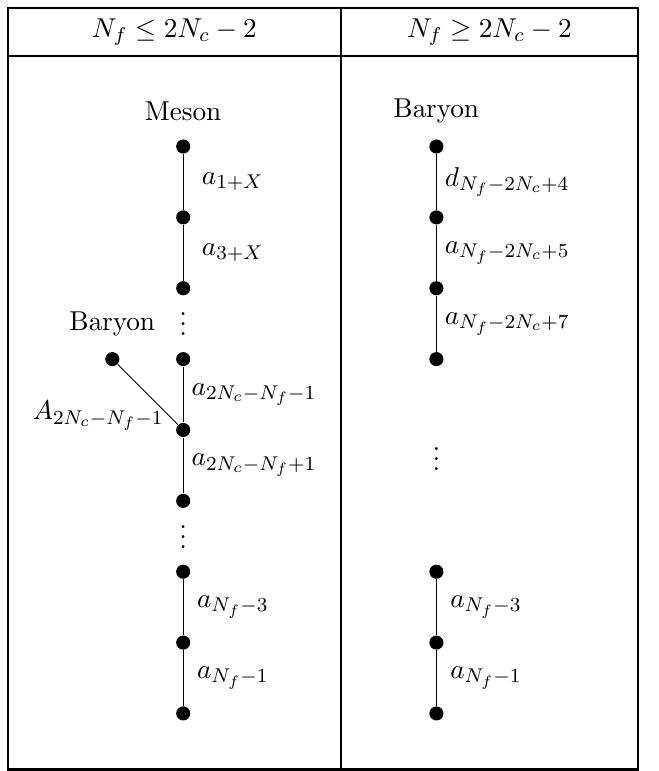
Table 7 . Hasse diagrams for the classical Higgs branch of SU( N c ) SQCD with N f flavors. Multi- plicities of the various leaves are not included, see section 5. For the diagram on the left, the bifurcation with the A 2 N bottom of the diagram a N − 1 is not reached before, i.e. when N c f even and X = 1 for N f